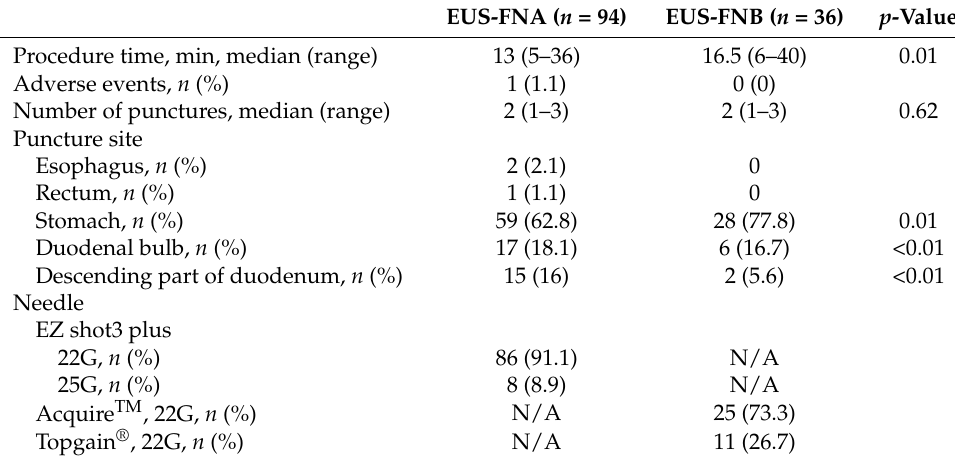
Table 2. Outcomes of EUS-FNA and EUS-FNB.